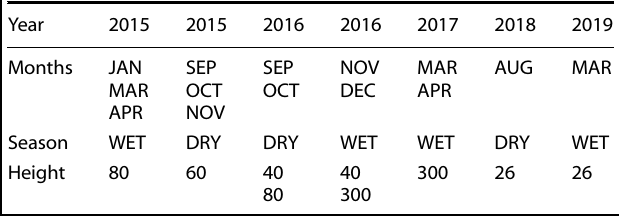
Table 1. Sampling calendar, describing the period (month and